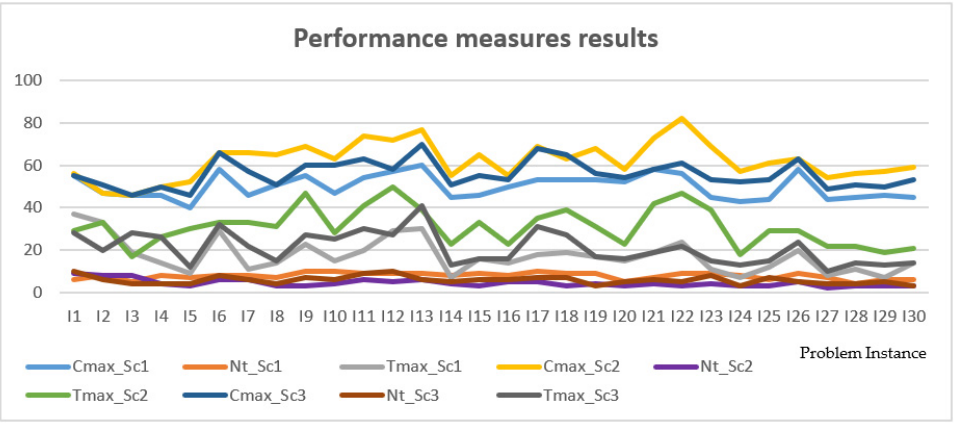
Figure 5. Performance measures’ values of the thirty scheduling problem instances from scenarios 1, 2 and 3. 2 and